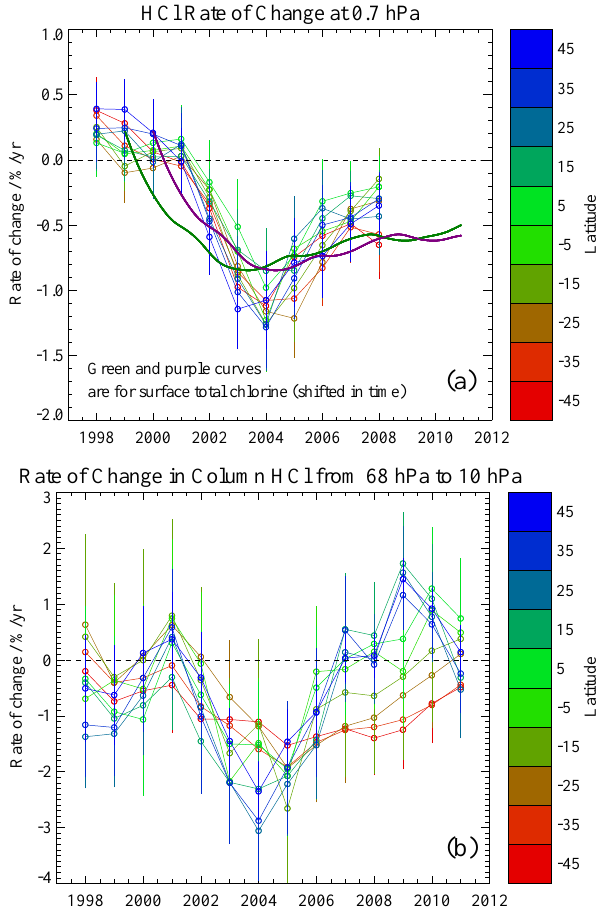
Figure 9. Rates of change for GOZCARDS HCl (connected open circles) are given as a function of latitude in 10 ◦ latitude bins for sliding 6-year periods centered on 1 January of each year (e.g., the 1998 point is an average for data from 1995 through 2000, and the 2011 point is for data from 2008 through 2013). (a) is for changes in upper-stratospheric HCl at 0.7hPa, and (b) is for the change in the integrated HCl column between 68 and 10hPa. The two additional curves in (a) represent the rates of change in the estimated surface total chlorine from NOAA data (green is for a 6-year time shift, and purple for a 7-year time shift, to account for transport time to the upper stratosphere); see text for more details. Error bars indicate twice the standard errors in the